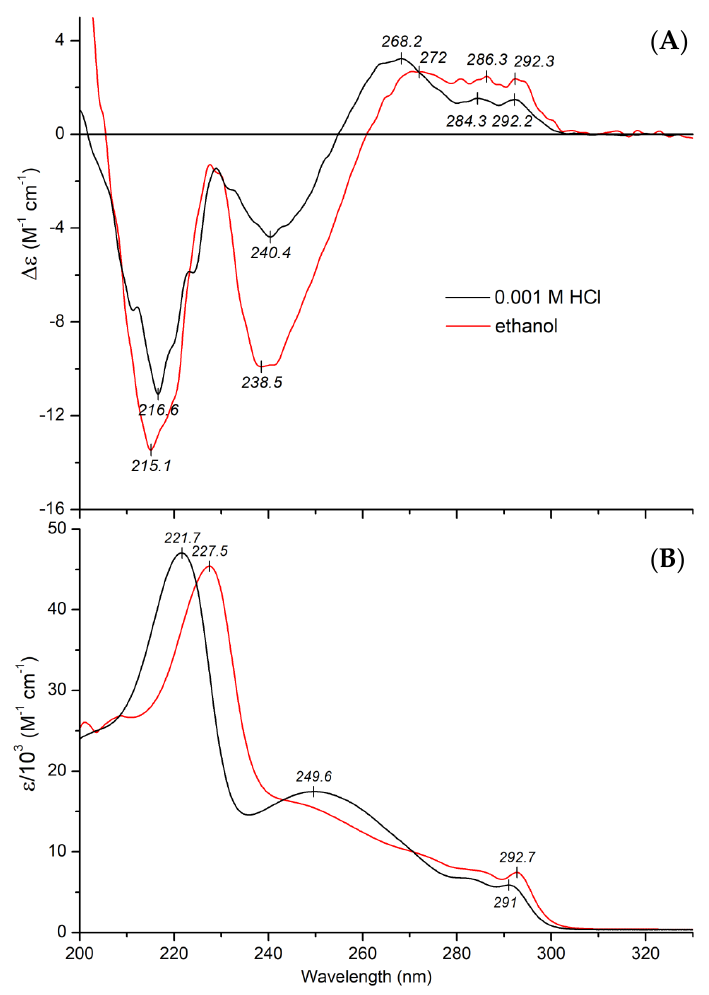
Figure 6. CD ( A ) and UV absorption ( B ) spectrum of 24 µ M mitragynine measured in aqueous HCl solution (pH~3) and in ethanol (50 µ L stock solution of MTR prepared in 0.001 M HCl was mixed into 1.8 mL